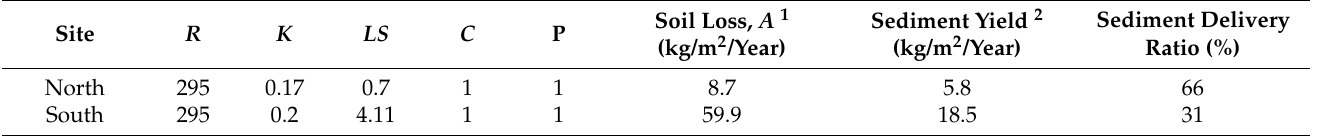
Table 4. USLE Method Parameters and Estimated Annual Soil Loss Rate, Sediment Yield, and Sediment Delivery Ratio for Wilson Creek’s North and South Construction